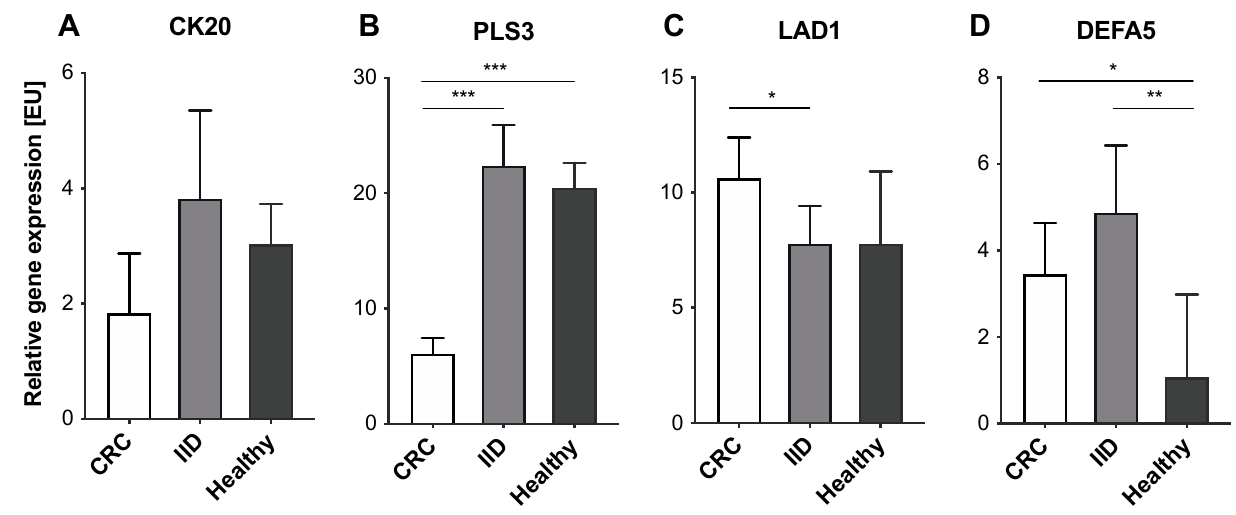
Figure 2. Expression levels of CTC-associated markers in blood samples of CRC and IID patients as well as healthy controls. MNC-derived cDNA from n = 98 CRC patients, n = 64 IID patients and n = 40 healthy controls was analyzed by RT-qPCR for expression of ( A ) CK20, ( B ) PLS3, ( C ) LAD1, and ( D ) DEFA5. Data are presented as median and at a 95% confidence interval. * p < 0.05; ** p < 0.01; *** p < 0.001 .